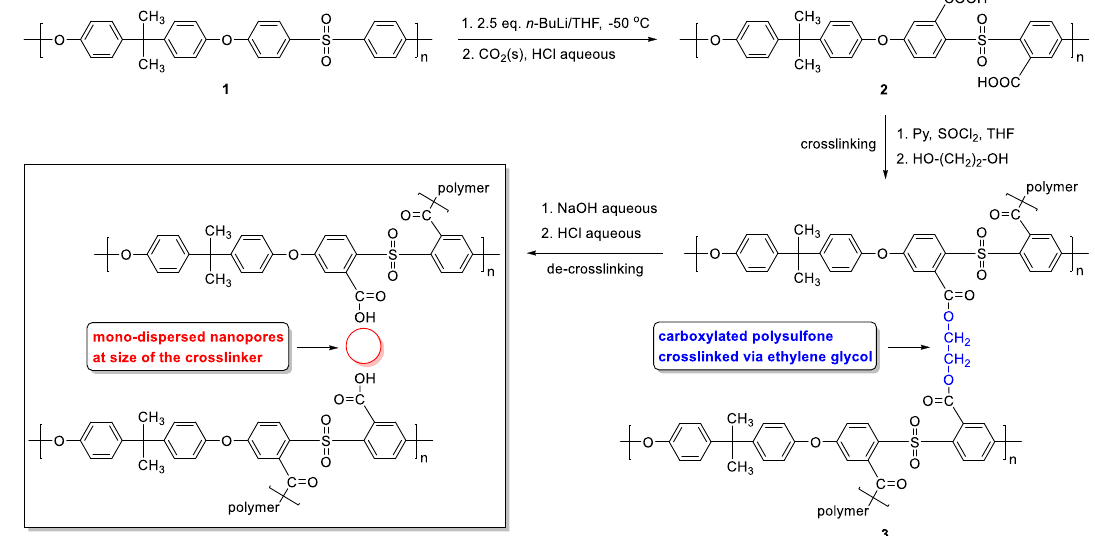
Scheme 2. Preparation of monodispersed nanoporous membranes by base hydrolysis of cross-